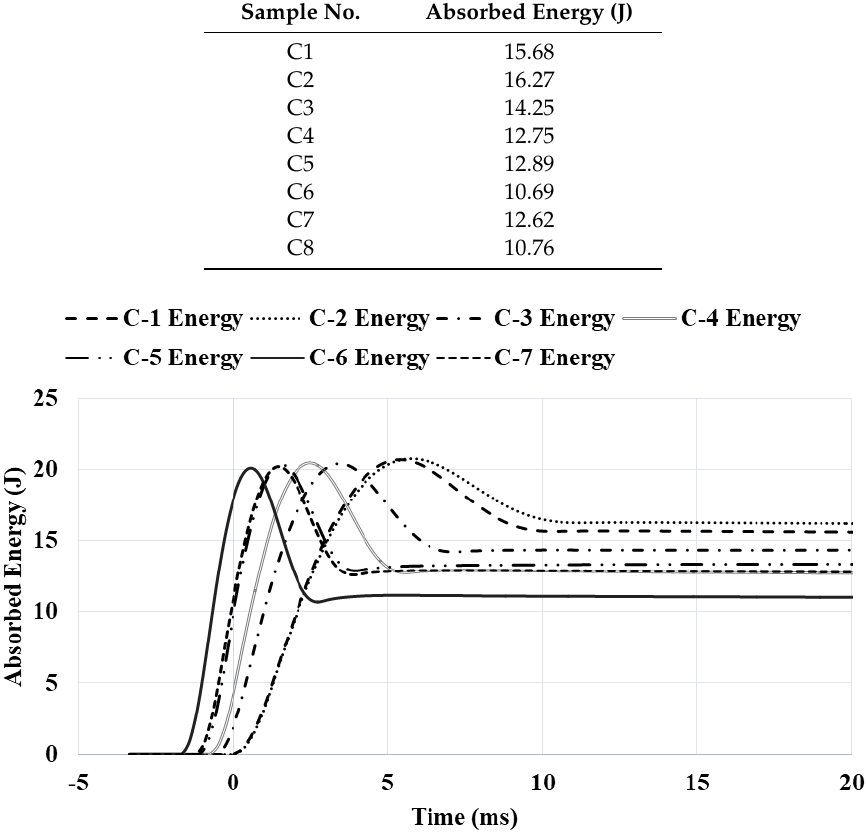
Table 3. Low-velocity impact test conditions and results for carbon-fiber plates. Sample No.